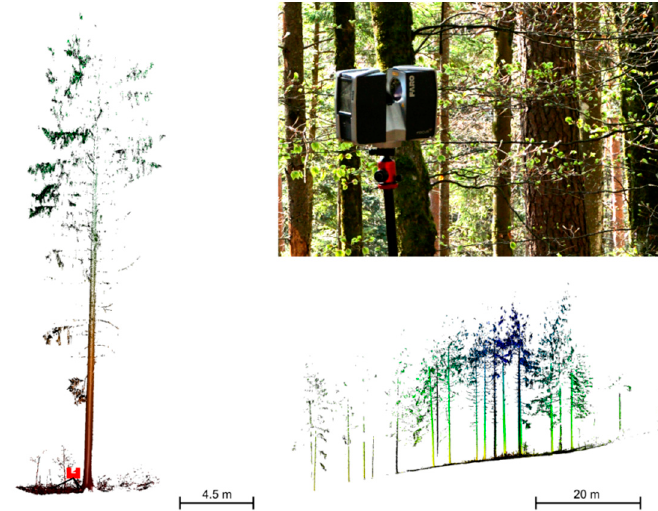
Figure 3. The left panel shows an example of dataset details for a single tree from TLS scanner ( top- right panel), the scanner position is illustrated by the red icon. In a 10 m long transect through the scan ( lower right panel), trunks are represented in high details whereas the depiction of crowns suffers from occlusion effects.